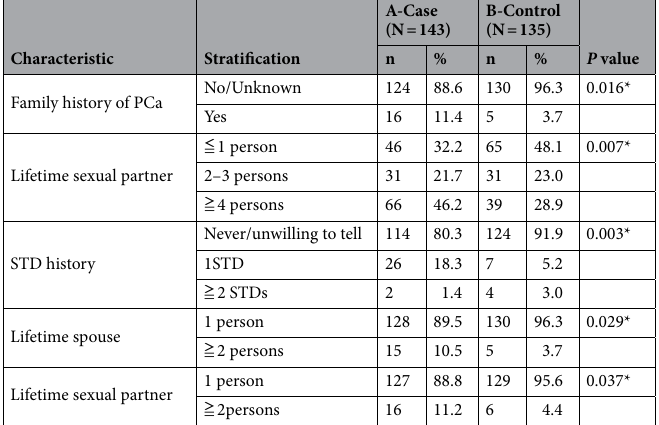
Table 2. Sexual characteristics, history of other sexually transmitted infections. * P <